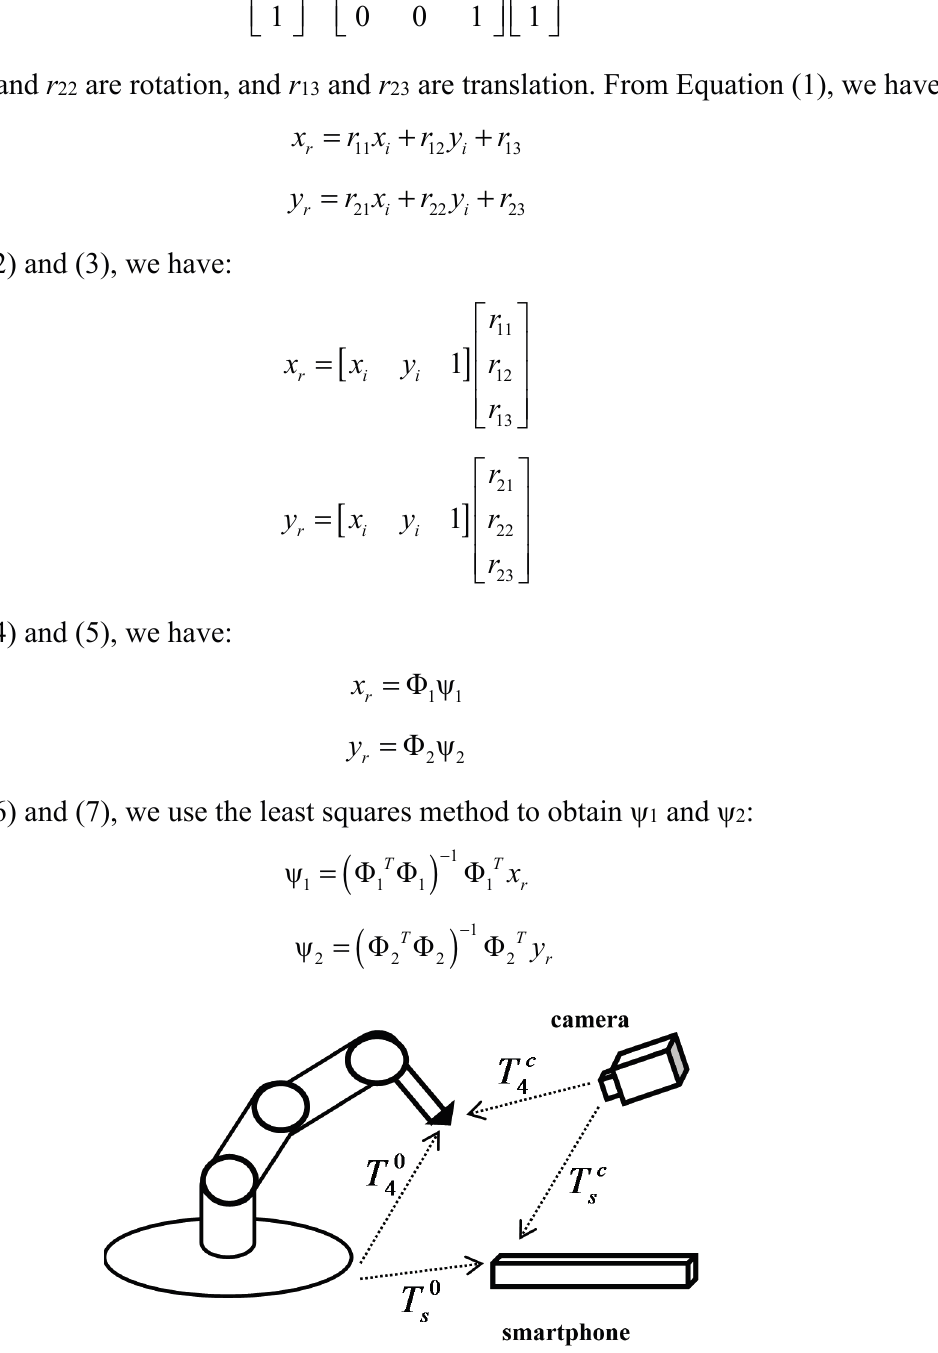
Figure 6. Coordinate transformation